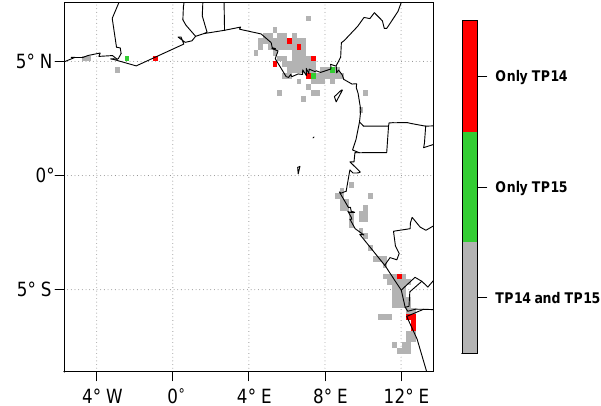
Figure 1. Flaring area for TP14 and TP15. Red (green) boxes de- note areas with flaring only for TP14 (TP15). For the gray areas, flaring is detected in both time